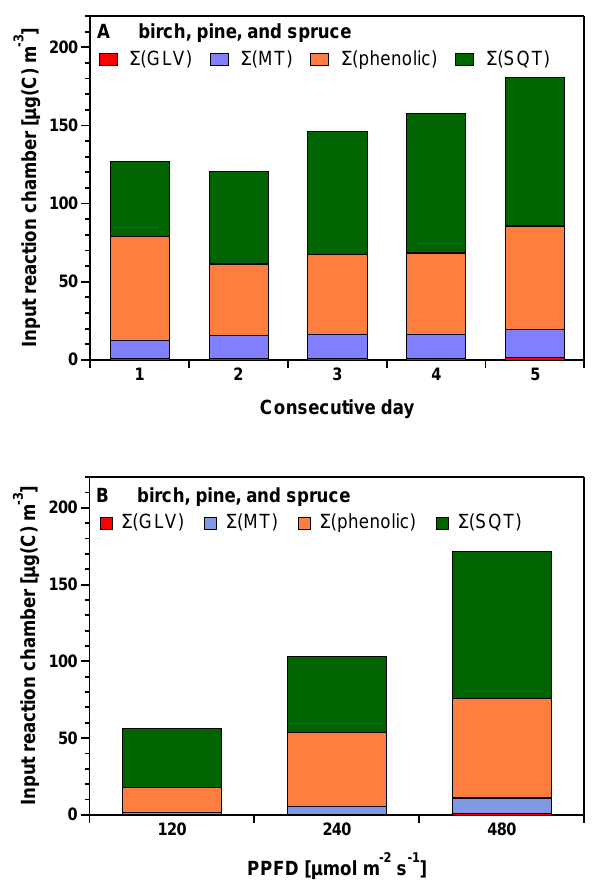
Fig. 1. BVOC concentrations at the inlet of the reaction chamber de- termined in Experiment #1. Concentrations were averaged for 4 h before particle formation was induced in the reaction chamber. GLV = green leaf volatiles, mainly C 6 -alcohols and –aldehydes with sig- nificant emissions only at day 5, MT = monoterpenes, phenolic = phenolic BVOCs originating downstream of the shikimate pathway, SQT = sesquiterpenes. (A) At constant PPFD = 480µmolm − 2 s − 1 and constant plant chamber temperature = 15 ◦ C, during a measure- ment period of five consecutive days. (B) At different PPFD and constant plant chamber temperature = 15 ± 0.5 ◦ C. Note that the pattern depicted for PPFD = 480µmolm − 2 s − 1 is not included in (A) .